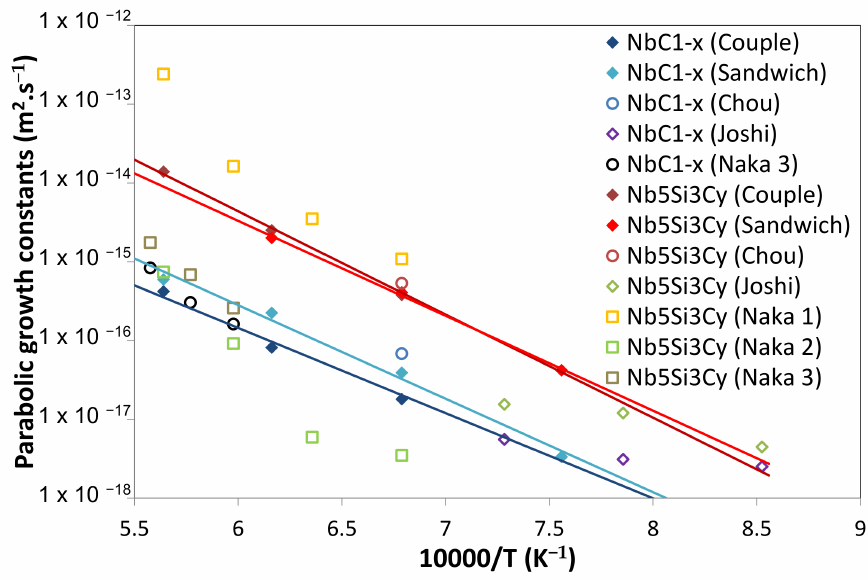
Figure 18. Comparison of the parabolic growth constants ( k ) of the different layers obtained in this study with the literature